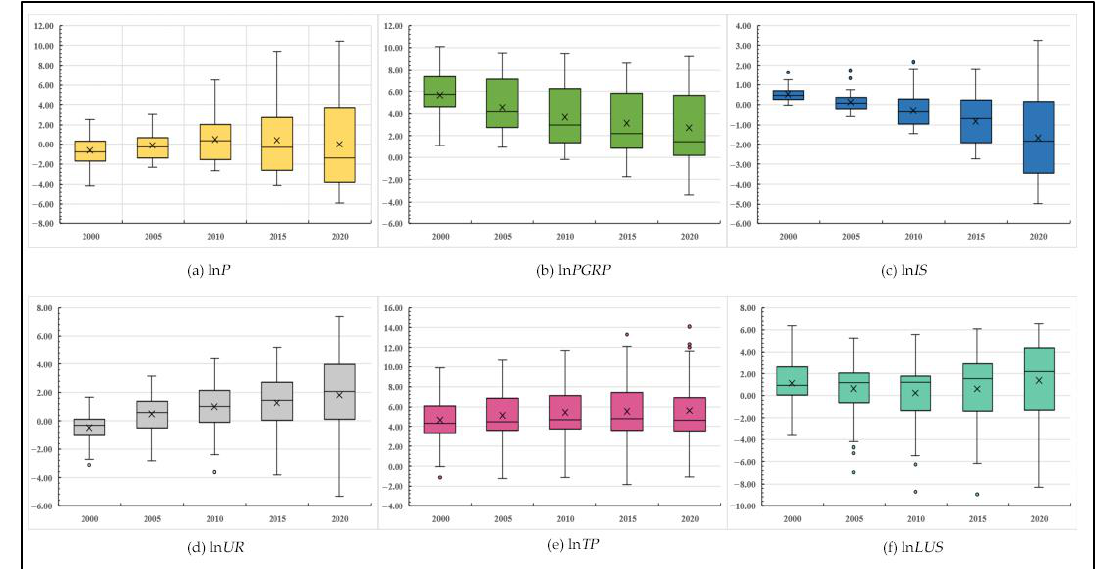
Figure 5. Driving mechanism coefficients of the land-use carbon emissions in the Yellow River Basin.